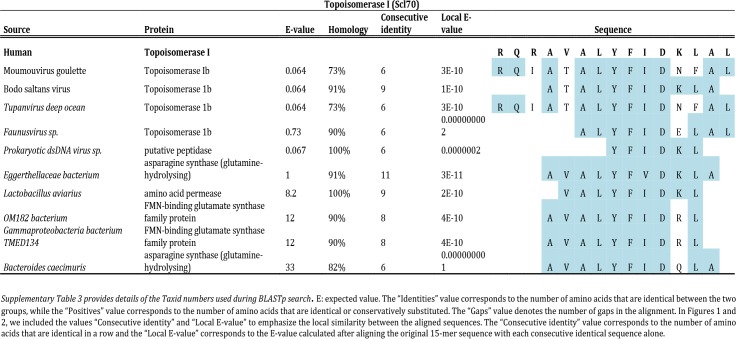
Representative microbial and viral mimics of topoisomerase I (Scleroderma 70, Scl70) dominant autoepitope.For each sequence (i.e. the 15-mer of and the 15-mer of topoisomerase I), the first five-homology pairs with viruses and the first five-homology pairs with bacteria were chosen, according to the following criteria:- The pairs ought to have at least 6 (≥6) consecutive homologous aa, allowing one aa difference, but of the same side chain group (i.e. I➔V or Y➔F)- Only one pair was chosen from same species- No pairs from phages were included- No pairs from uncultured bacteria or viruses were included- No hypothetical proteins were included